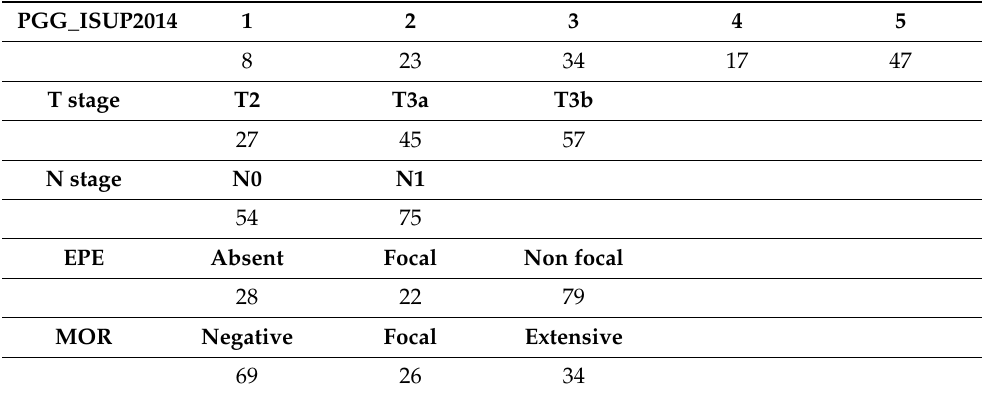
Table 1. Pathologic characteristics of the patients.